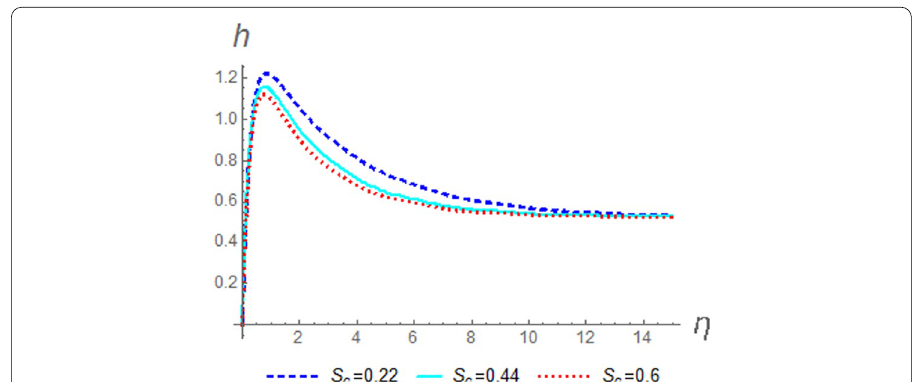
Fig. 14 Effect of S c on the velocity profile